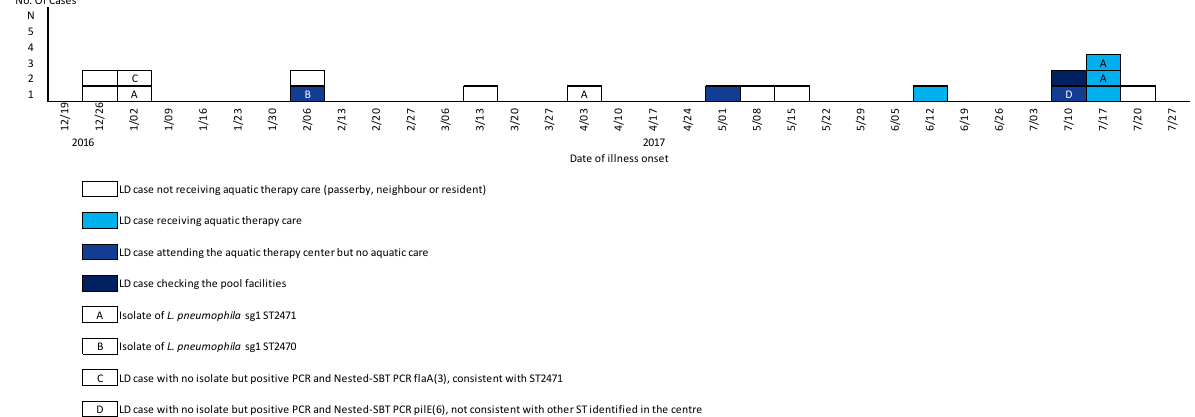
Figure 1. Outbreak of Legionnaires’ disease in a district in the city of Montpellier, December 2016 to July 2017 ( n = 18). Potential exposures and dates of illness were obtained from patient interviews and microbiological analyses performed by NRC-L.